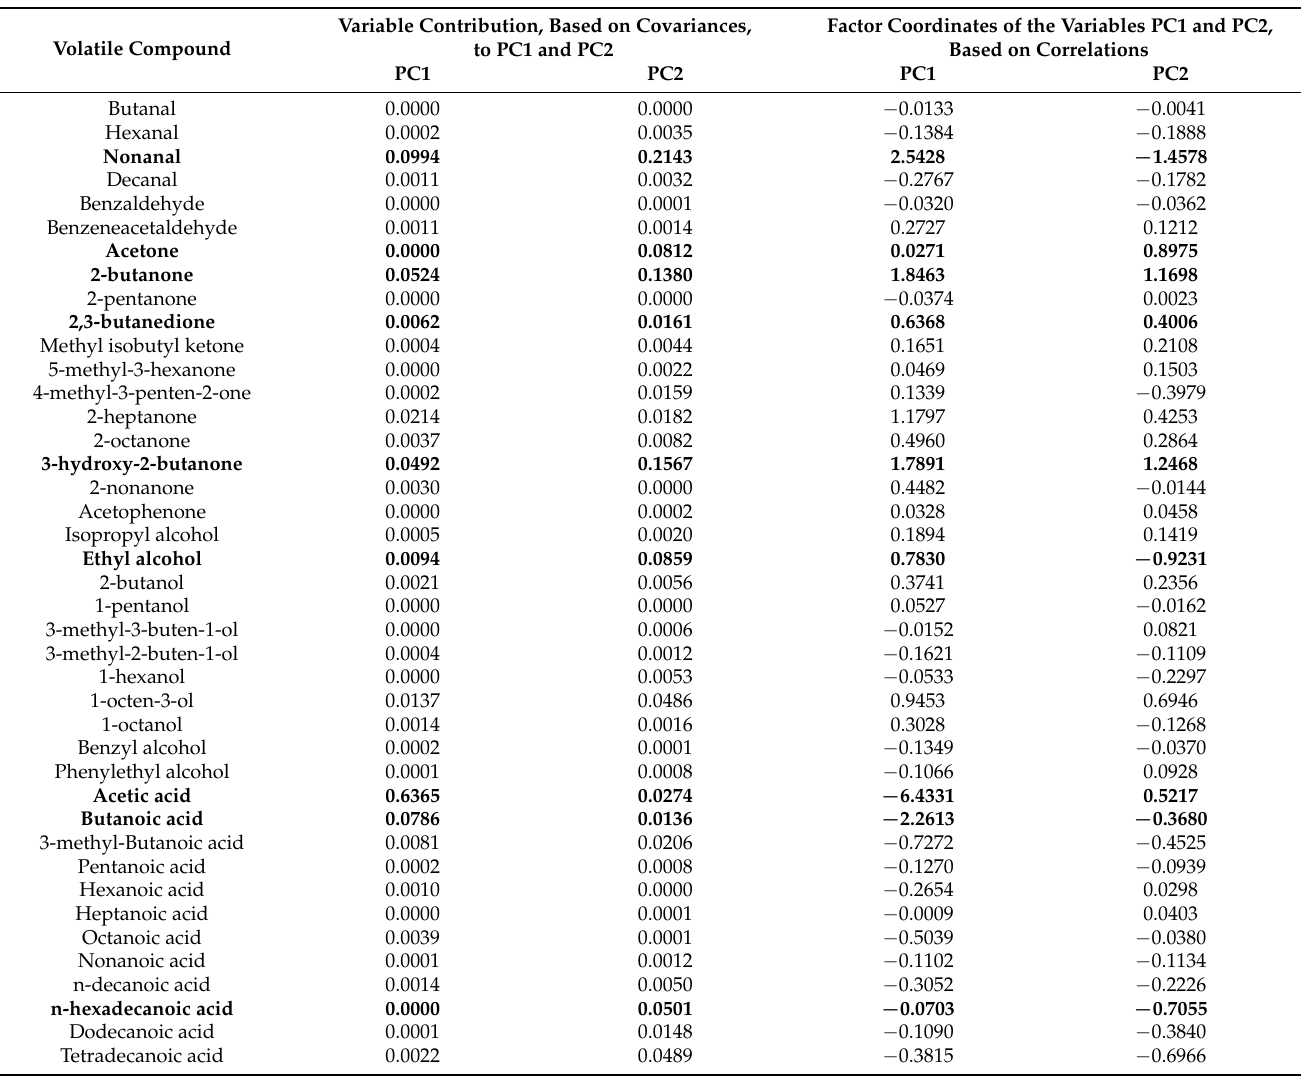
Table 3. Variable contribution and relative factor coordinates of the volatile compounds for PC1 and PC2. Compounds with higher contribution (>0.05) to at least one of the first two Principal Components are reported in